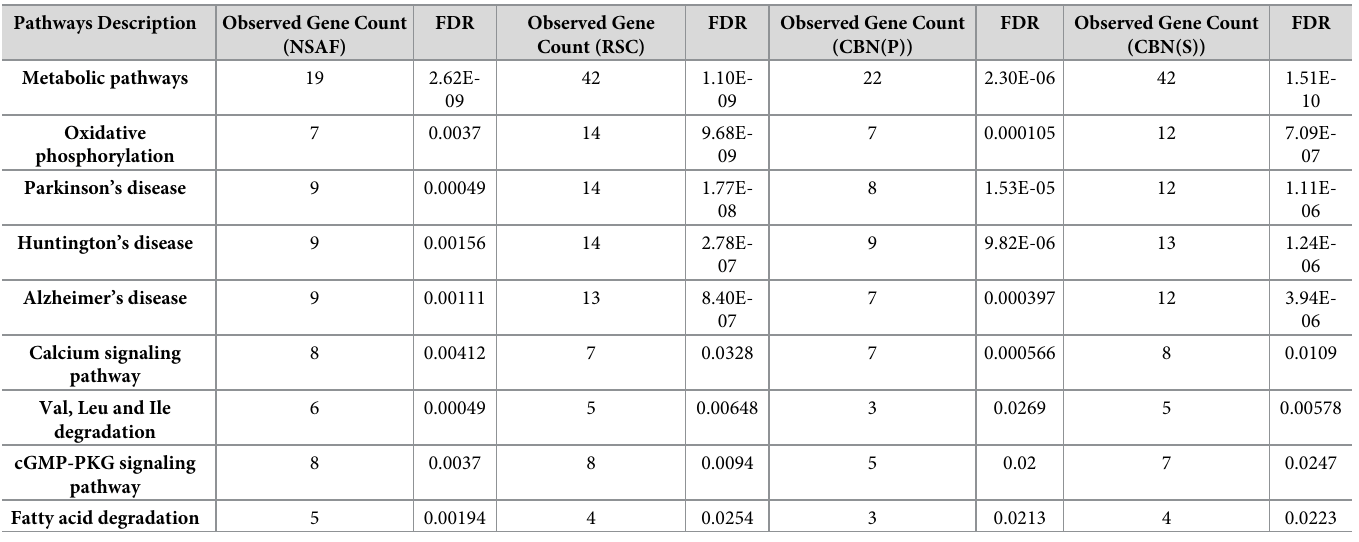
Table 3. List of functional pathways identified by STRING